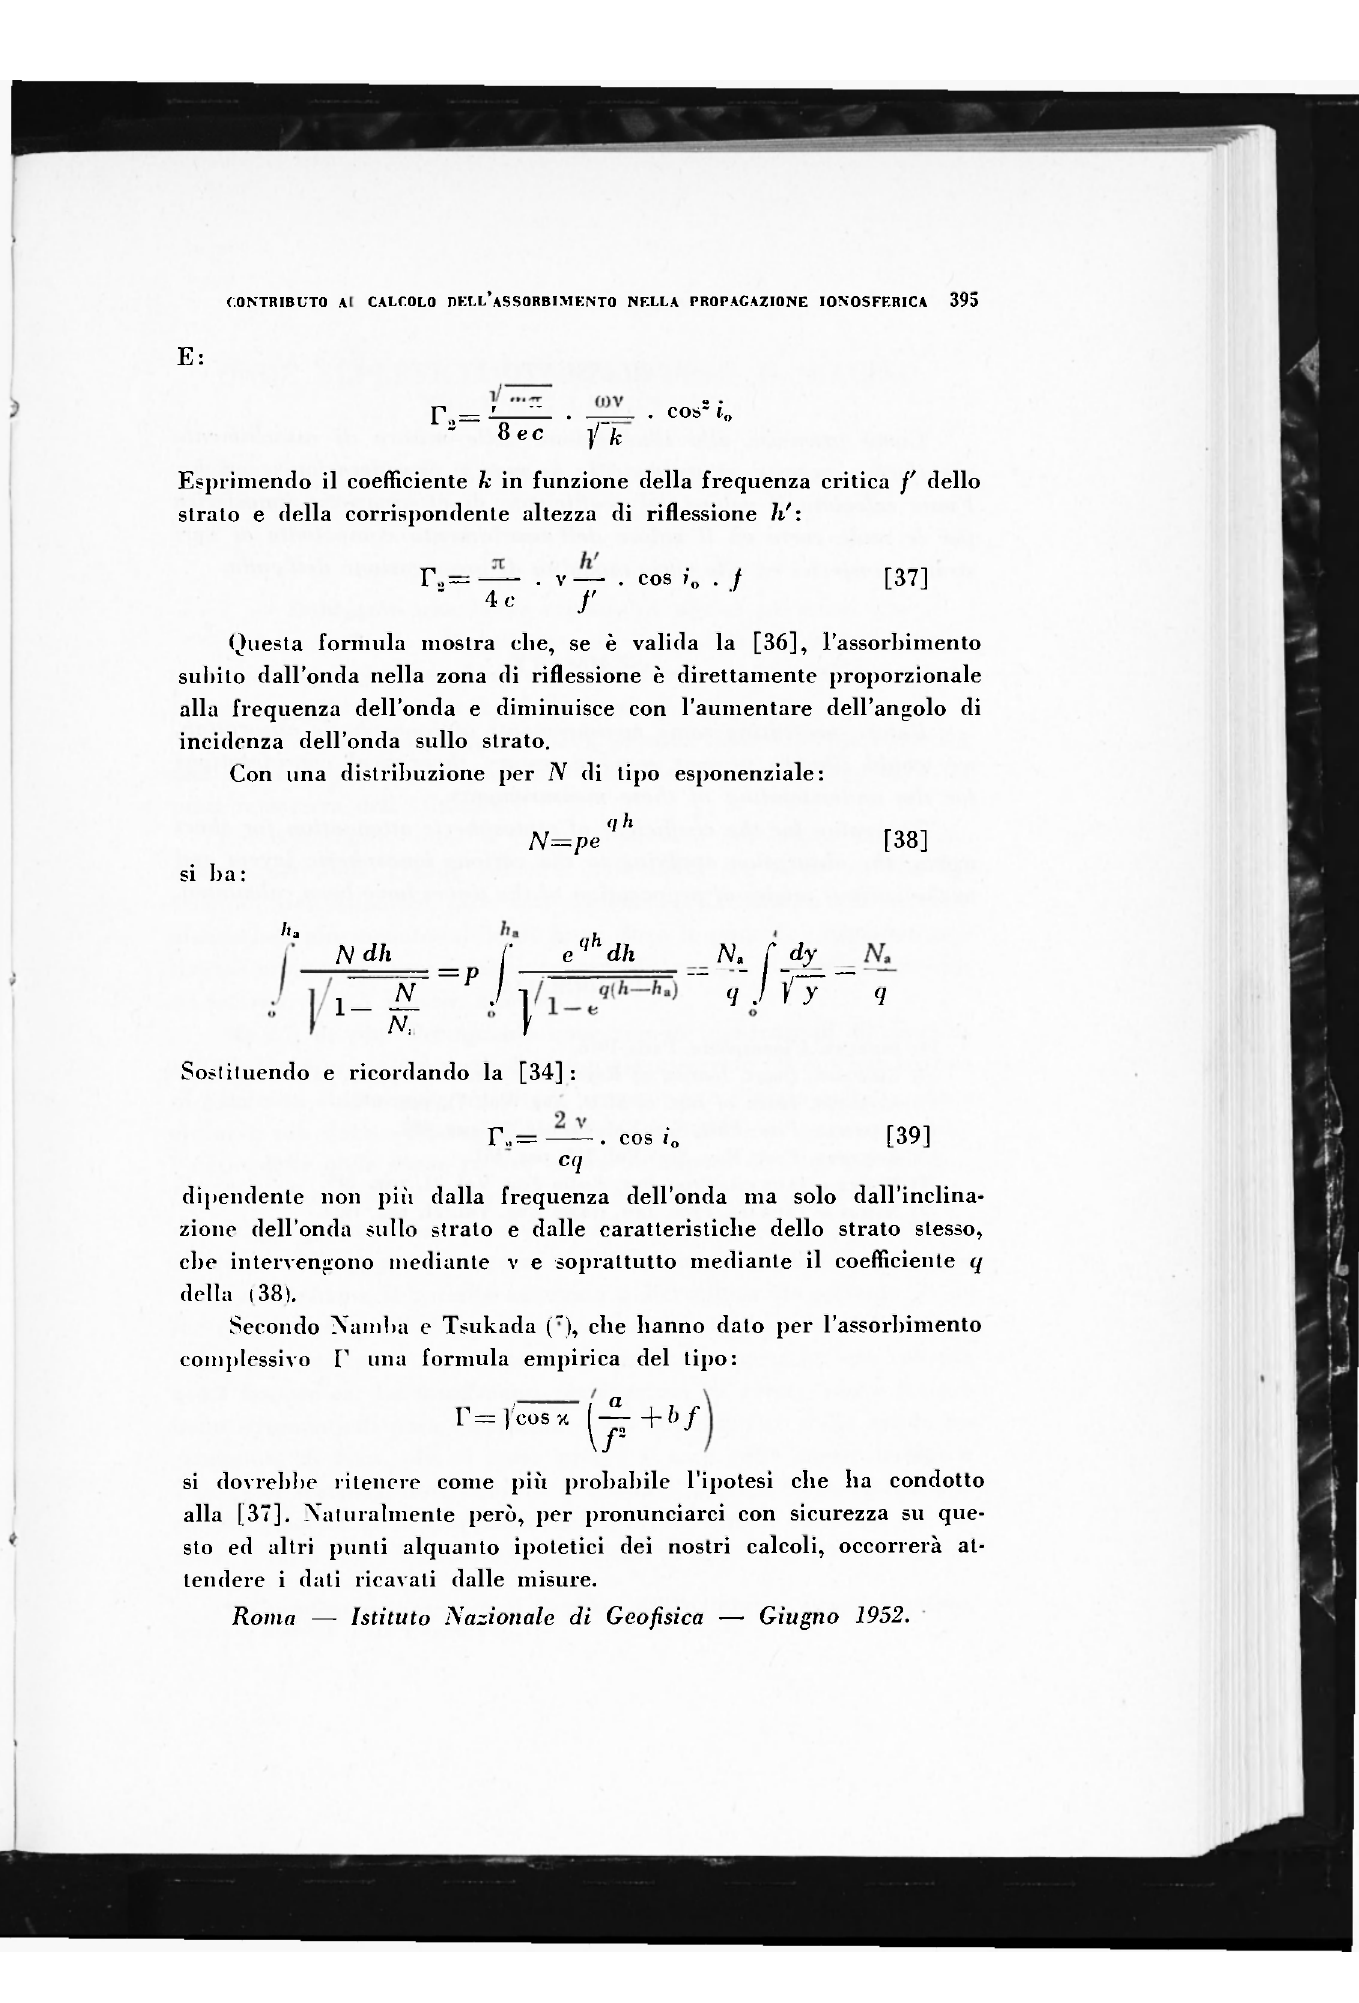
r.= — . v— . cos i a . f [37] ' 4 c